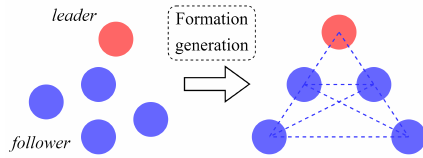
Figure 2. Formation